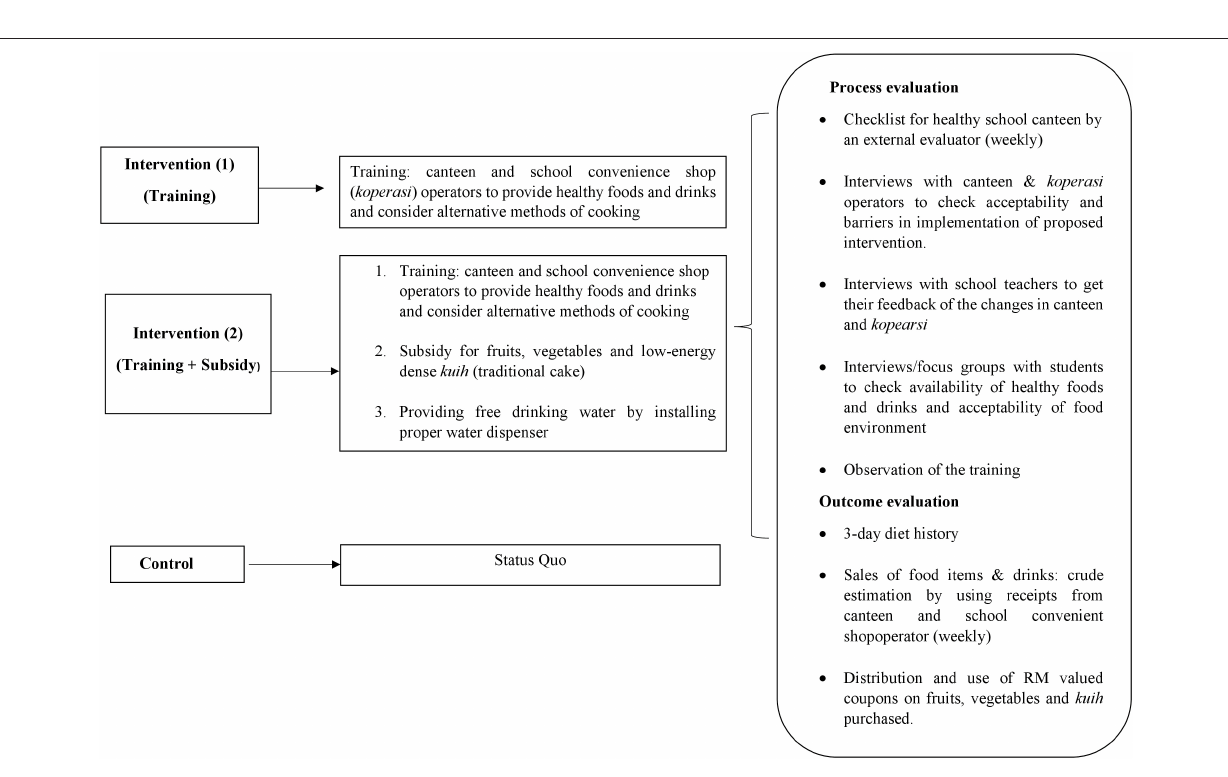
FIGURE 2 | Logic model of